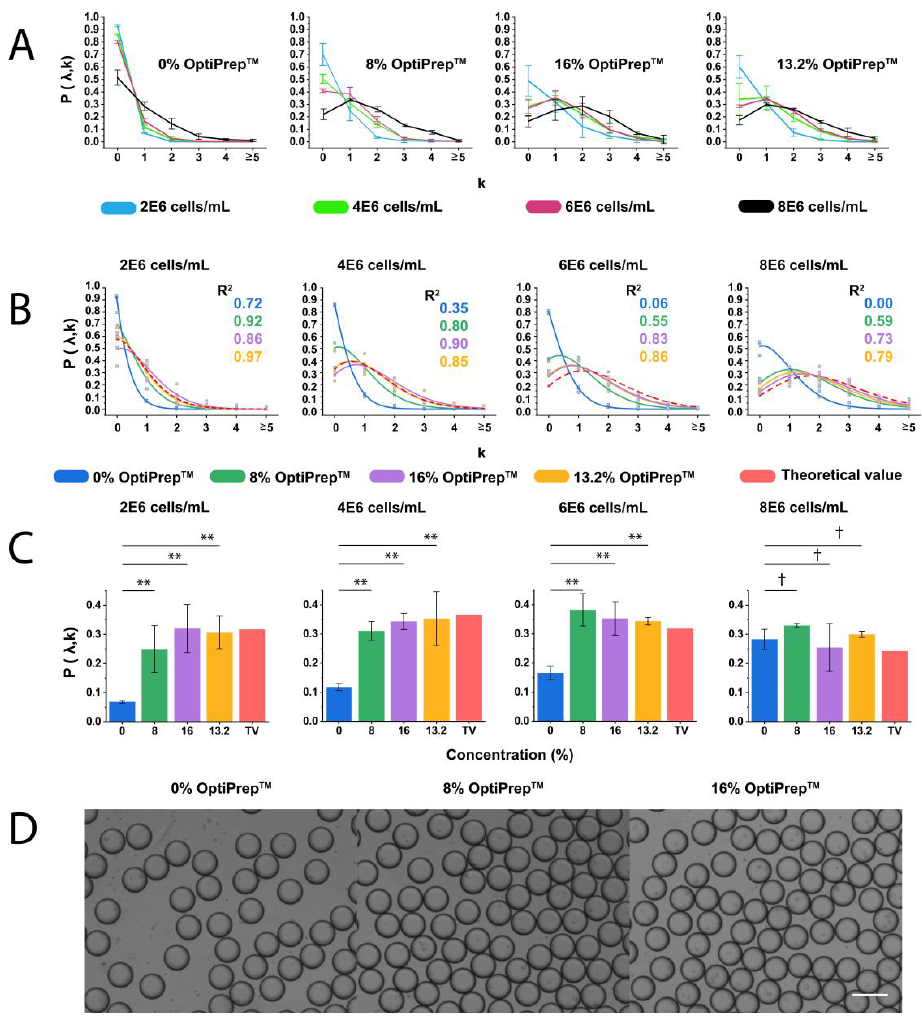
Figure 3. Cell encapsulation in microdroplets at di ff erent cell and OptiPrep TM concentrations. ( A ) Plots of probability of THP-1 cell encapsulation in 81 µ m droplets at di ff erent concentrations of OptiPrep ™ (0%, 8%, 13.2%, and 16%) and cells (2 × 10 6 , 4 × 10 6 , 6 × 10 6 , and 8 × 10 6 cells / mL). From the left to right: experimental values at 0% OptiPrep ™ , 8% OptiPrep ™ , 16% OptiPrep ™ , and optimized OptiPrep TM (13.2%), and theoretical values predicted by Poisson distribution for cell encapsulation of 81 µ m droplets. At least 100 droplets were counted for each measurement, and the experiment for each condition was duplicated three times. Error bars represent the standard deviation. The probability P ( λ , k) indicates the proportion of droplets containing k cells (0, 1, 2, 3, 4, and (cid:61) 5). ( B ) The comparison between the theoretical and experimental results of cell encapsulation in microdroplets. Plots of the probability P ( λ , k) values for droplets containing di ff erent number of cells (0, 1, 2, 3, 4, and (cid:61) 5) obtained from experiments and Poisson statistics are shown. R 2 refers to the coe ffi cient of determination of di ff erent groups fitting Poisson distribution. ( C ) ANOVA test results for the rate of single-cell encapsulation in droplets. A comparison between experimental values and theoretical value (TV) at di ff erent concentrations of OptiPrep TM was performed for each cell concentration. ** represents p < 0.01; † means no significant di ff erence. n = 3, error bars represent the standard deviation. (D) Photographs of cell-laden microdroplets generated with the presence of OptiPrep ™ at di ff erent concentrations. From the top to bottom: 0% OptiPrep ™ , 8% OptiPrep ™ , and 16% OptiPrep ™ in cell suspensions. Cell concentration was 4 × 10 6 cells / mL. Scale bar = 100 µ